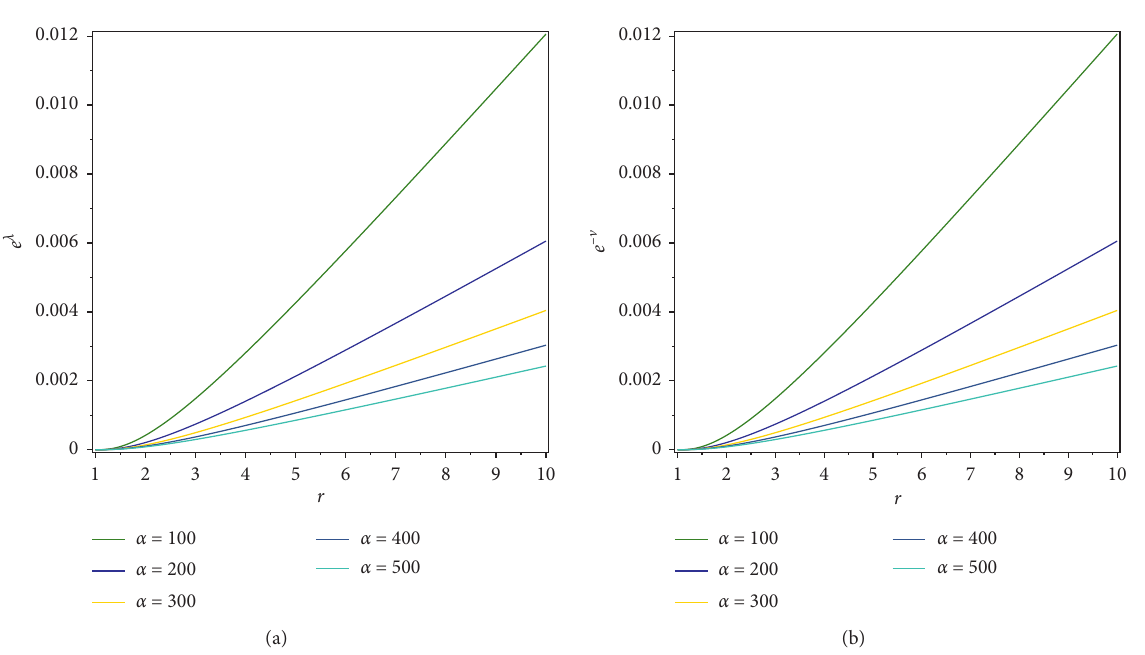
Figure 2: Plots of metric potentials corresponding to r